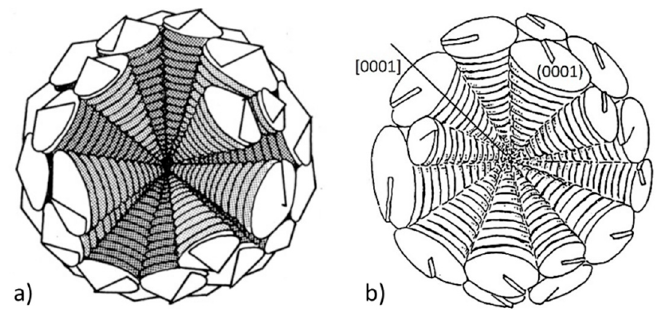
Figure 34. Models for growth of graphite spheroids: ( a ) The Double-Hellawell cone-helix (micro-spiral) model, reproduced after [125] with permission from Elsevier; ( b ) spiral-dislocation growth of conical sectors, reproduced after [29] with permission from Springer.